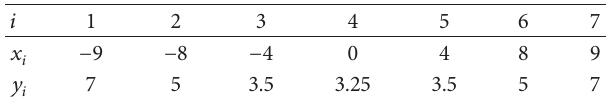
Table 5: A convex data